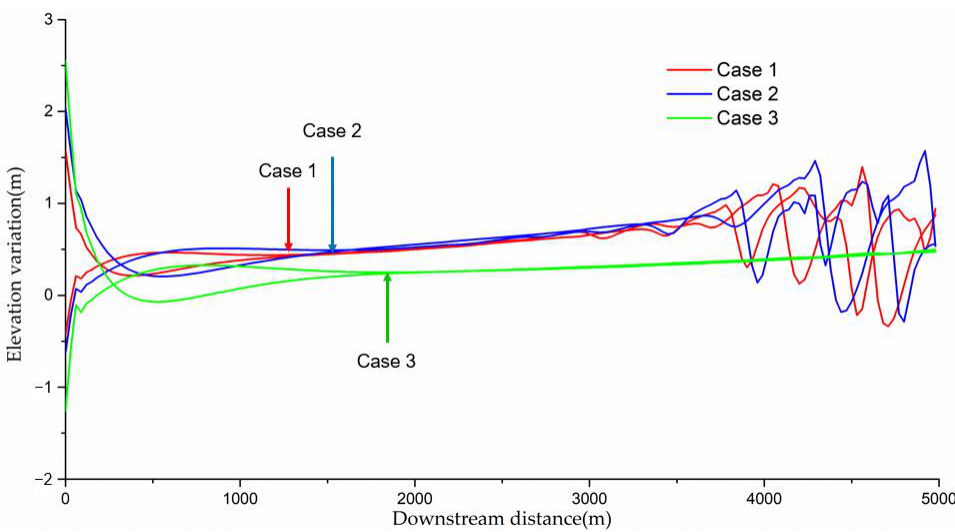
Figure 10. Elevation variation at the upper reach of the channel of Cases 1, 2, and 3 when discharge is maximum/minimum.